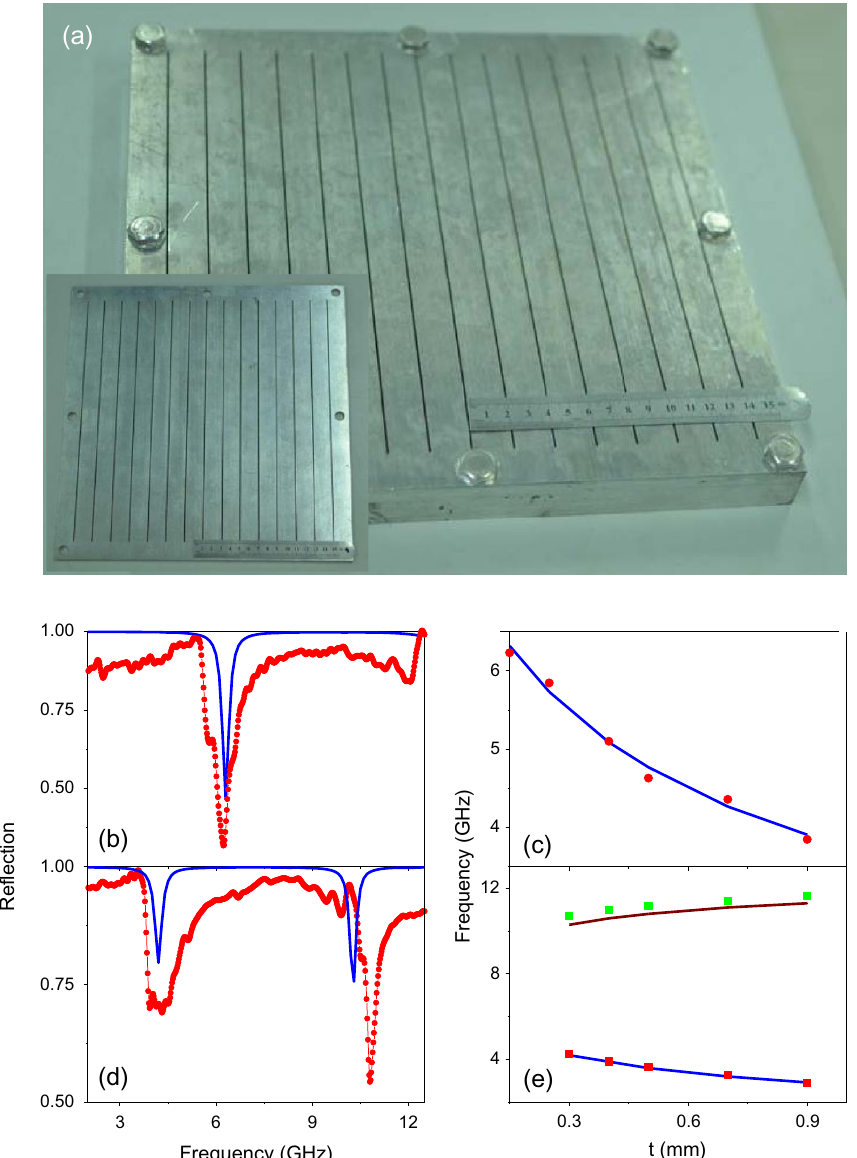
Figure 6. Experimental results for the microwave band: (a) Photographs of the fabricated samples. The lattice constant of the two samples is d = 20 mm, the slit width is a = 1 mm, and the grating thickness is h = 5 mm and 10 mm, respectively. The measured (the circles) and calculated (the line) reflection spectra are presented in (b) for h = 5 mm, t = 0.15 mm and (d) for h = 10 mm, t = 0.3 mm, respectively. The measured (the circles) and calculated (the lines) resonance wavelength of the two samples as a function of spacer thickness t are shown in (c), h = 5 mm, and (e), h = 10 mm,